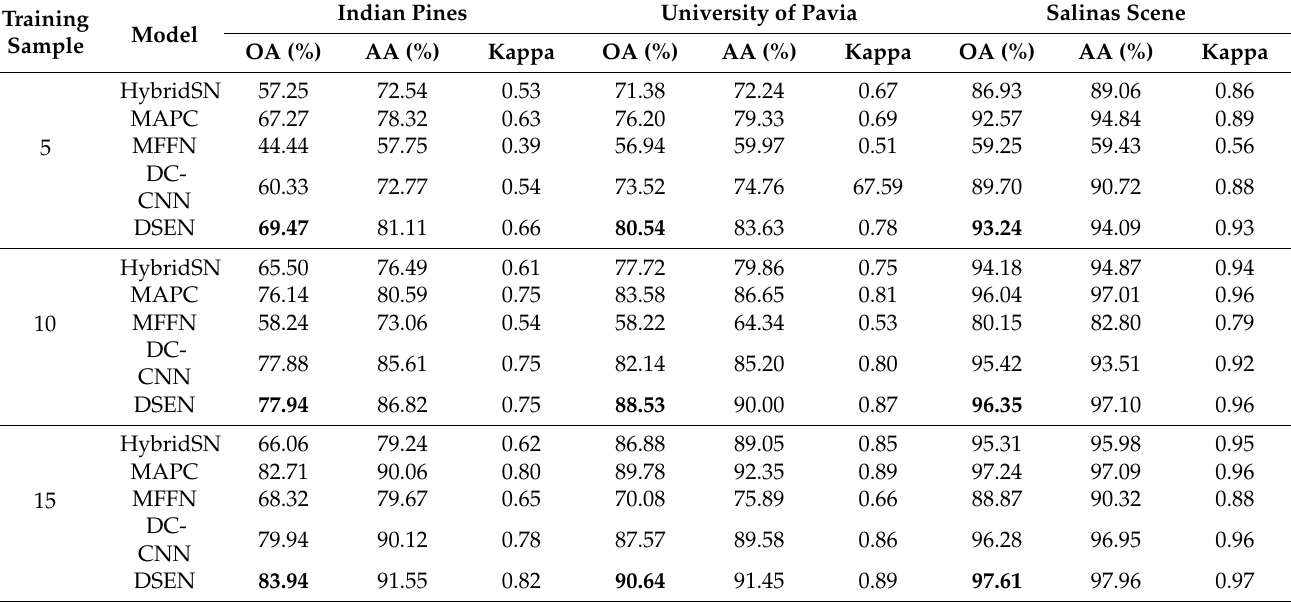
Table 8. Classification results of